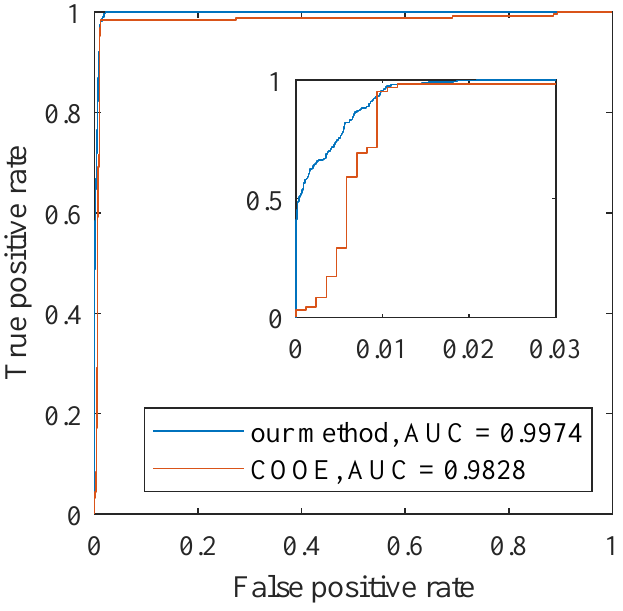
Figure 6. The ROC curves of the two methods in semi-real